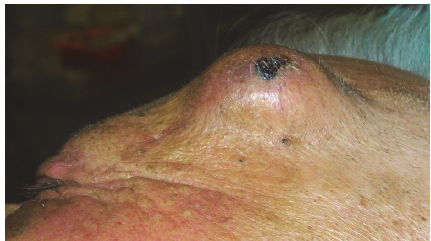
Figure 1: Pulsatile mass at the temporal side of the left frontal lobe.